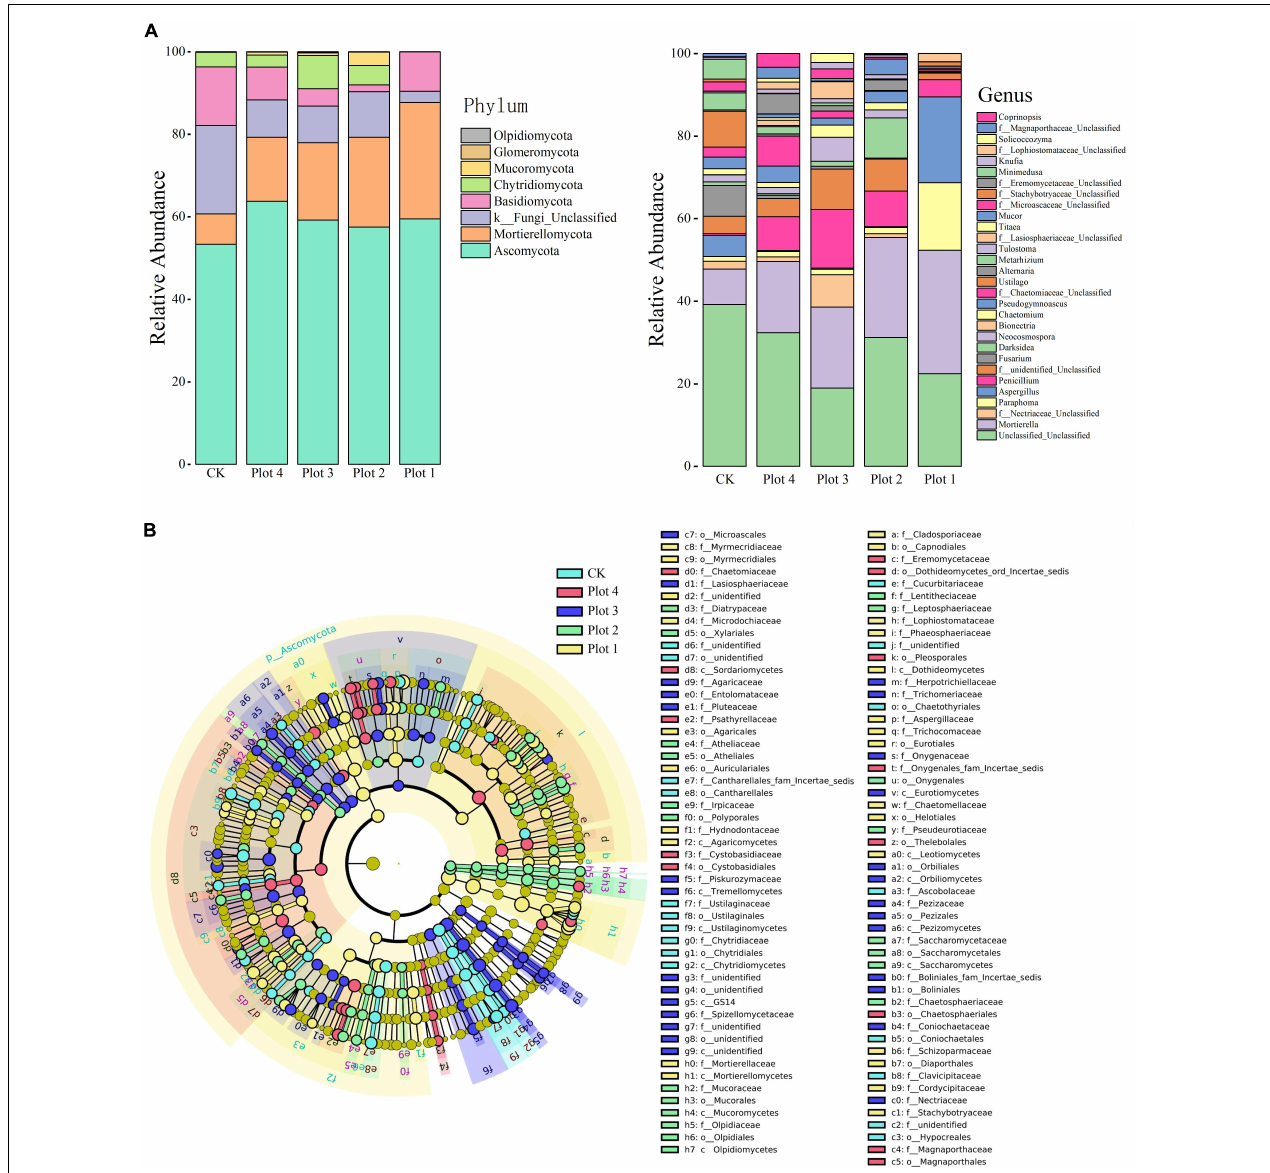
FIGURE 3 | (A) Structural composition of soil fungi at phylum and genus level. (B) LEfSe of the fungal communities with an LDA score higher than 4.0. In cladogram, circles radiating from inside out represent fungal taxa from phylum to genus, the diameter of which is proportional to the relative abundance of each taxon. Taxa with significant differences were marked with the same color as the highest-ranked sampling point of that taxa, and the branching regions were shaded. A taxon without a significant difference is marked in yellow. CK represents soil in a reference plot with native Hippophae rhamnoides vegetation on the mine site, and Plot 4, Plot 3, Plot 2, and Plot 1 represent soils with Hippophae rhamnoides vegetation reclaimed on the mine site in 2007, 2012, 2015, and 2017,